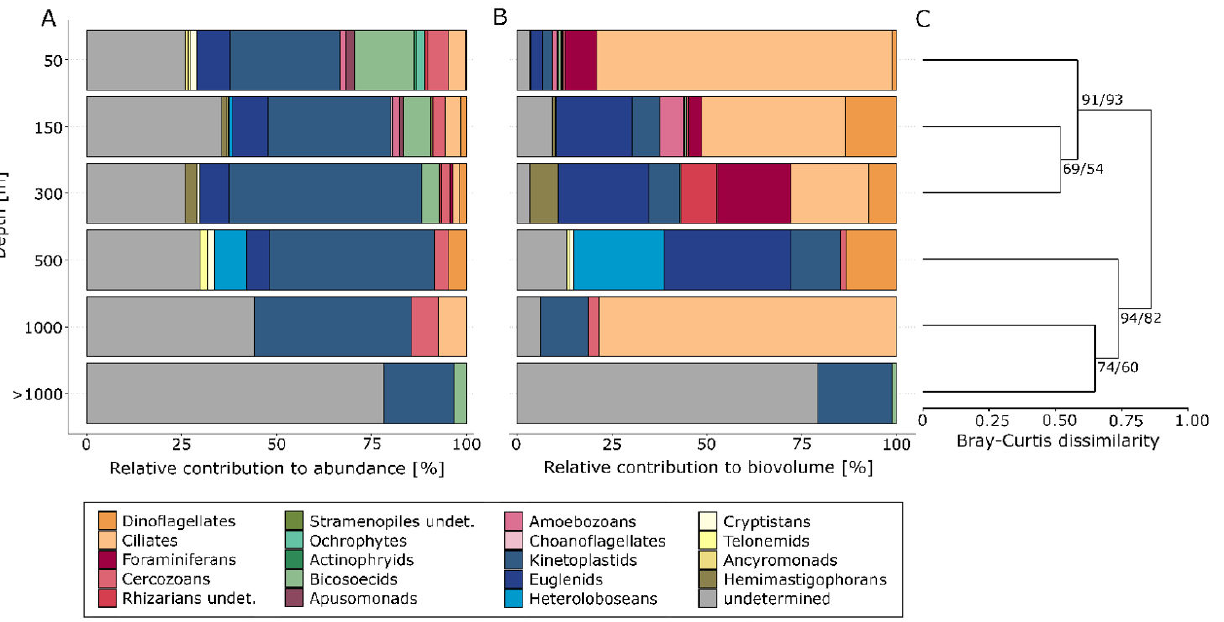
Figure 3. Relative contribution to ( A ) abundance and ( B ) biovolume of taxonomic groups detected by live-counting of samples from sublittoral to abyssal depths (different stations of the same depth were pooled, depths from 1500 to 3000 m were pooled and displayed as >1000 m). ( C ) Cluster dendrogram of all different depths based on the Bray–Curtis dissimilarity and the UPGMA clustering analysis with approximately unbiased (AU) p -values and bootstrap probability (BP) values given at the branching points of the